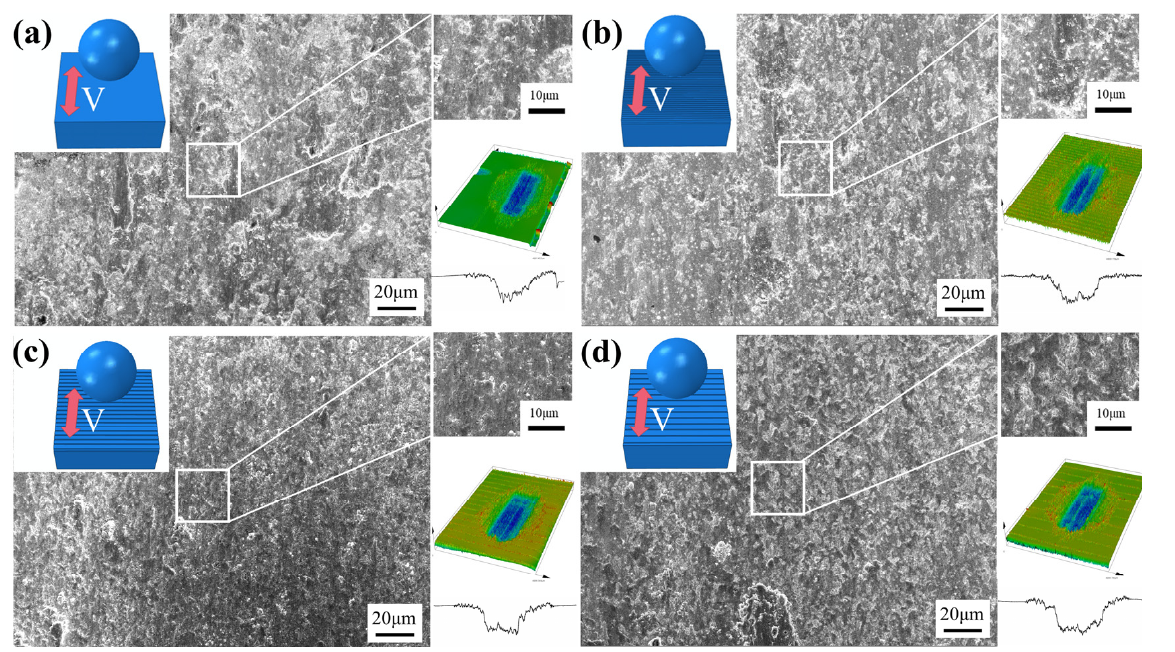
Figure 12. The SEM and LCM morphologies of the worn YG6X surface of ( a ) G0, ( b ) G1, ( c ) G2, and ( d ) G3 when sliding with TC4.